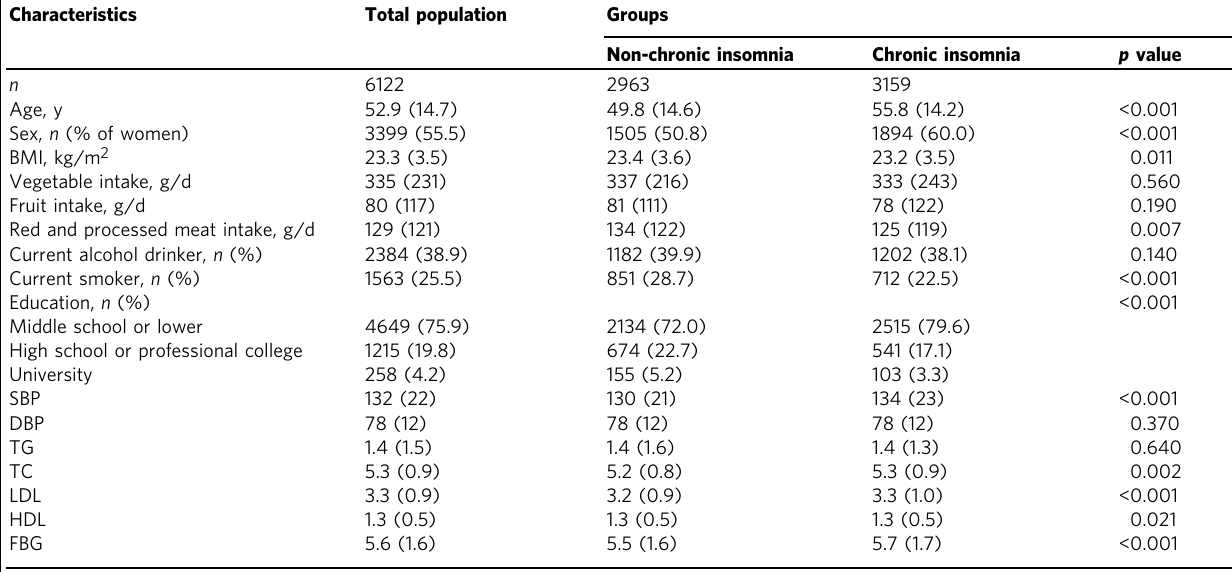
Table 2 Characteristics of study participants from the Guangdong Gut Microbiome Project a .